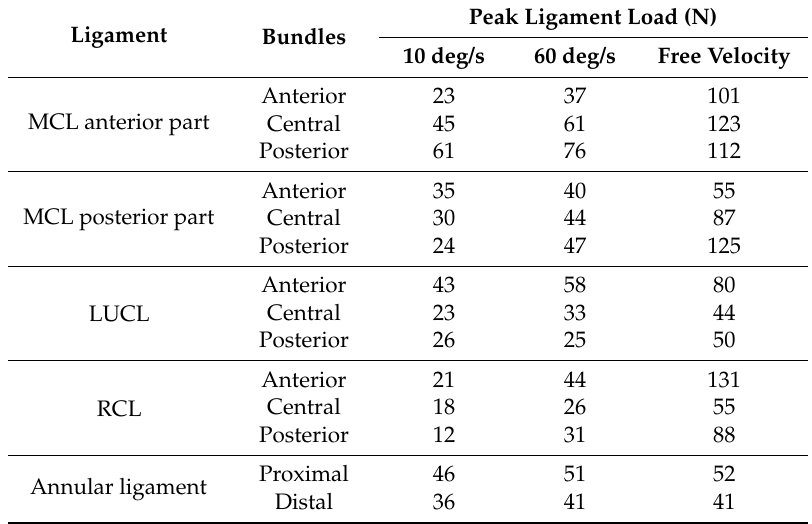
Figure 7. Normalized experimental electromyography (EMG) and normalized muscle forces from model prediction. ( a ) 10 deg/s; ( b ) 60 deg/s; ( c ) free velocity. Muscle forces are normalized to the maximum force produced by each muscle for the specific trial. Table 3. Ligament peak load throughout the simulation period for different velocity